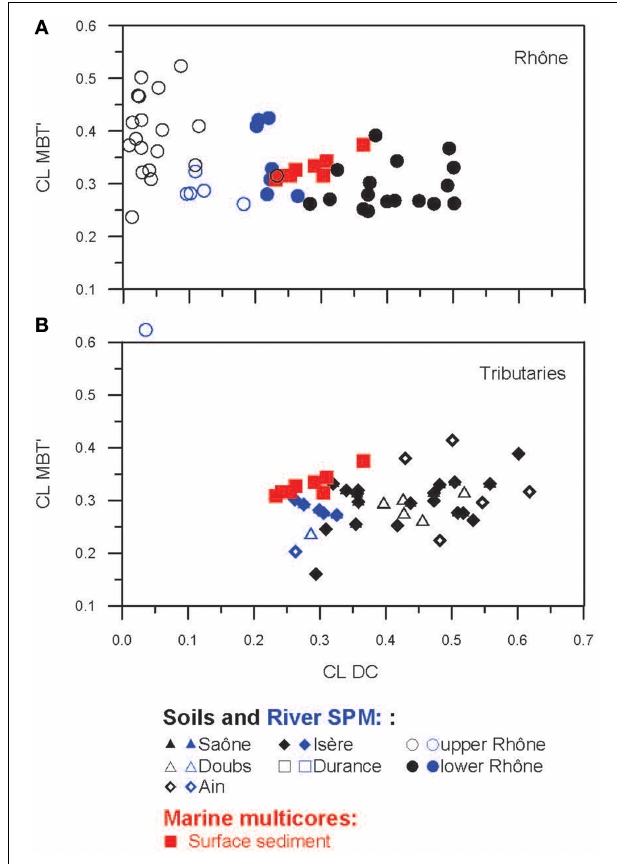
FIGURE 10 | Scatter plots of the DC vs. the MBT’ of CL brGDGTs from soils and river SPM collected in (A) the Rhône and (B) its tributary basins in addition to marine surface